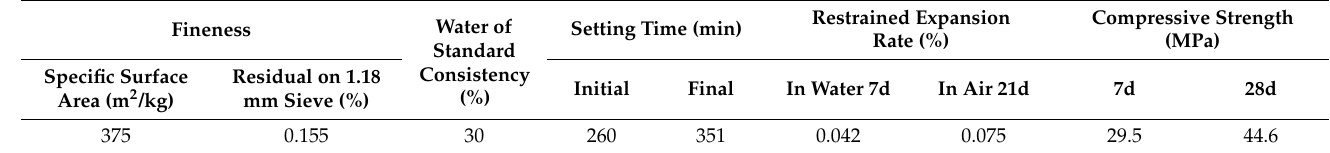
Table 3. Physical and mechanical properties of the expansion agent (HEM-V).